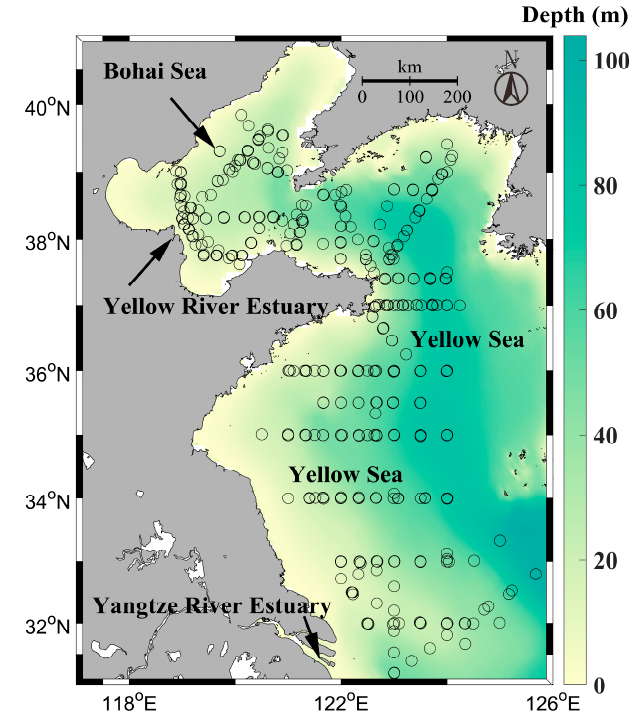
Figure 1. Locations of sampling stations in the Bohai Sea and the Yellow Sea during four cruises in 2013, 2014, and 2016. The colors indicate bathymetry. The thickened black line represents the selected section, which is expressed as section A, B, and C, respectively, from north to